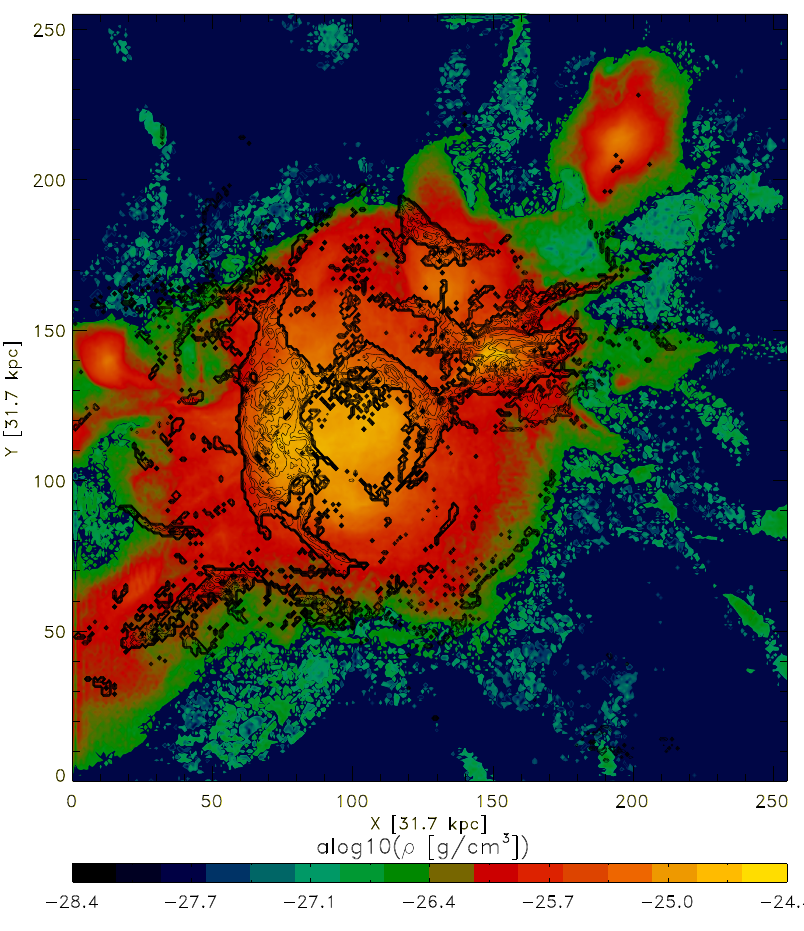
Figure 1. Projected gas density (colours) and radio contours at z ≈ 0.2. Two radio relics can be seen on the right ( P radio ≈ 3.42 × 10 31 erg/s/Hz) and left ( P radio ≈ 2.26 × 10 32 erg/s/Hz) side of the cluster centre.